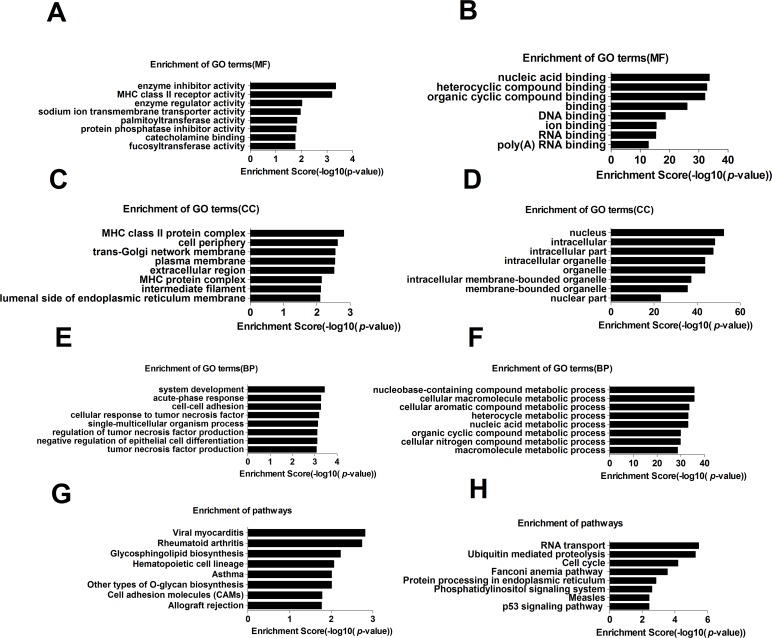
Enrichment analysis of GO terms and pathways for differentially expressed mRNAs.The top 8 GO analyses (which consisted of a cellular component (CC), molecular function (MF), and biological process (BP)) (A-F) and top 8 pathways (G,H) that exhibited significant differences between RA and HC are listed (left and right panels show the upregulated and downregulated coding genes, respectively).